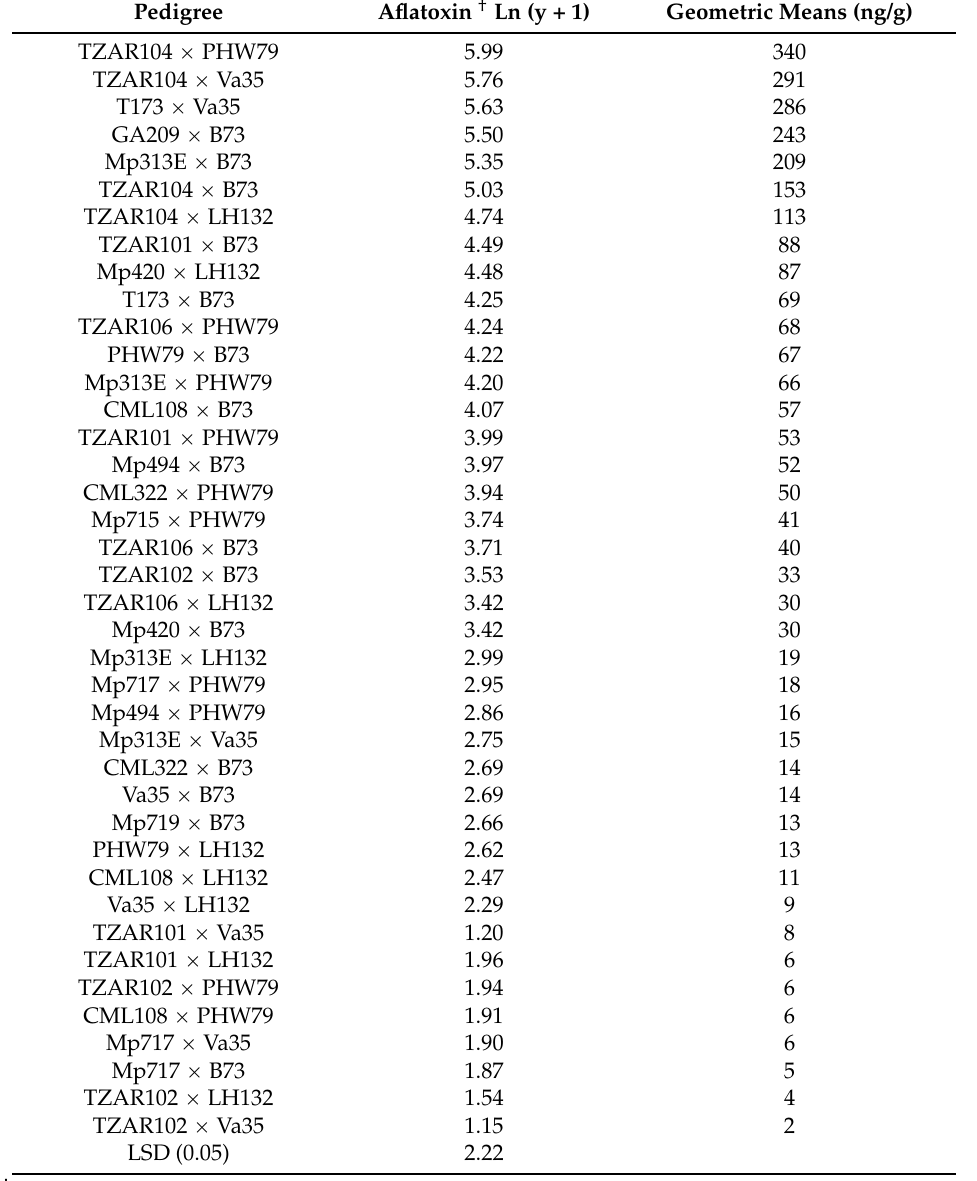
Table 5. Aflatoxin accumulation in testcrosses evaluated at Mississippi State in